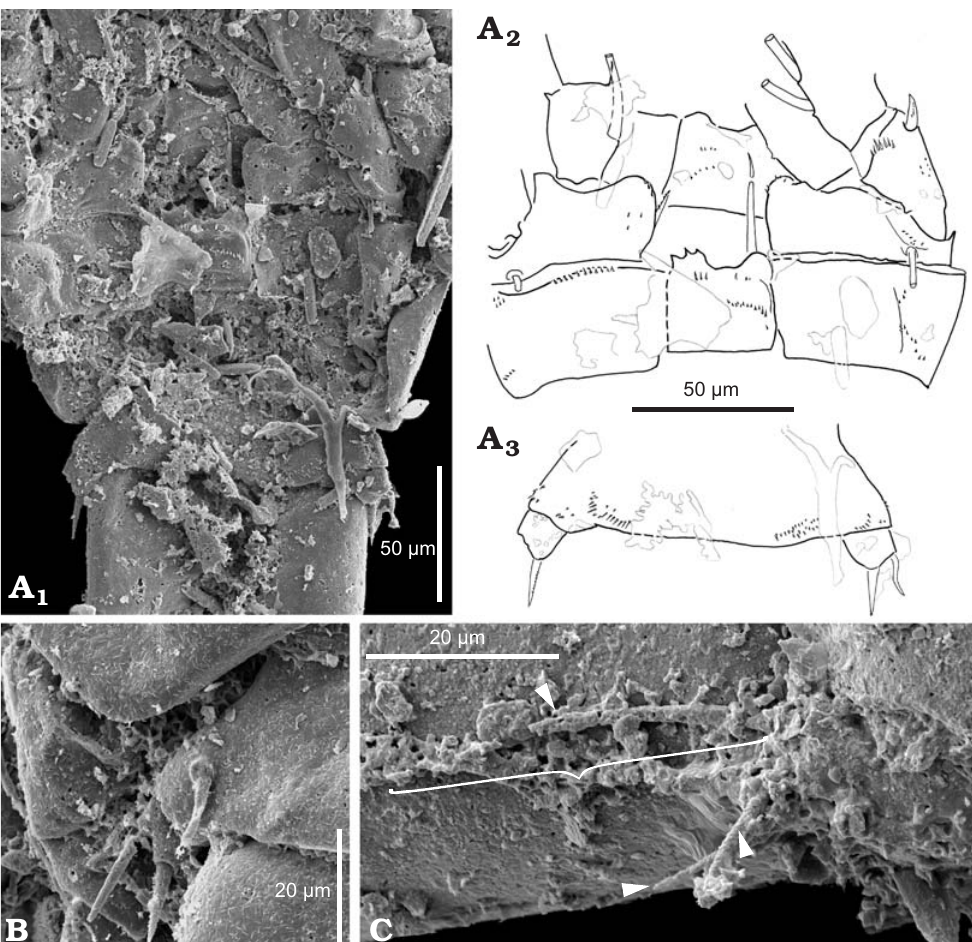
Fig. 6. Adult male of cyclopid copepod Apocyclops californicus sp. nov. from Mud Hills, Southern California; Burdigalian–Langhian, Miocene. A . UMNH IP 4850. Protopodite and proximal segments of the exo- and endopodite of leg 4 (caudal view), and pediger 5 in ventral view (A 1 ). Drawings of protopo- dite and proximal segments of the exo- and endopodite of leg 4, and intercoxal sclerite of leg 3 in caudal view (A 2 ) and pediger 5 with leg 5 in ventral view (A 3 ). B . UMNH IP 4856, pediger 5 with leg 5 in dorsal view; lateral seta of presumptive proximal segment of leg 5 is inserted on pediger 5. C . UMNH IP 4828, leg 6 in lateral view; arrowheads show the three setal elements, whole length of the lateralmost seta is indicated by bracket.